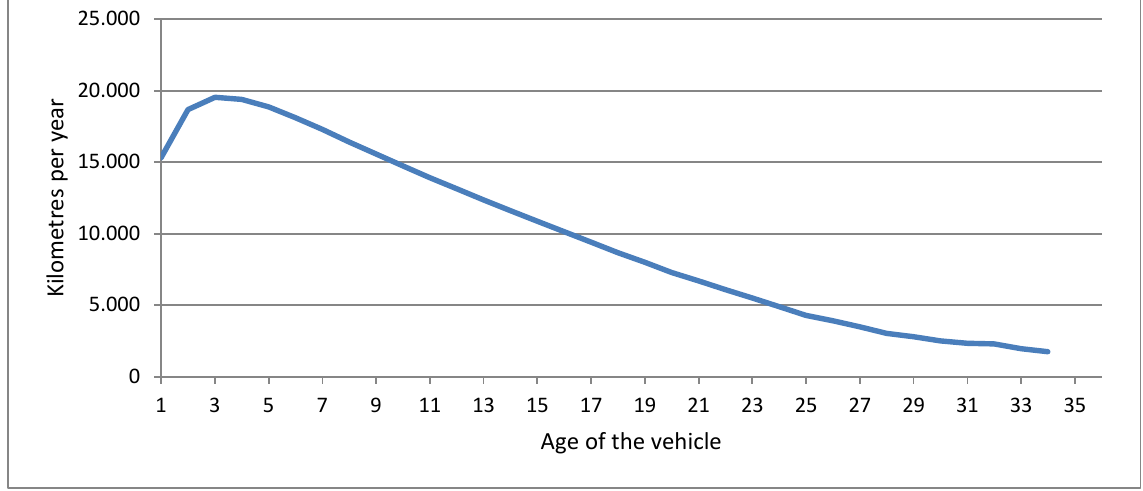
Figure 1. Average kilometres driven per year by LCVs according their age (Source: GOCA, 2015) Maintenance, repair and tyre replacements